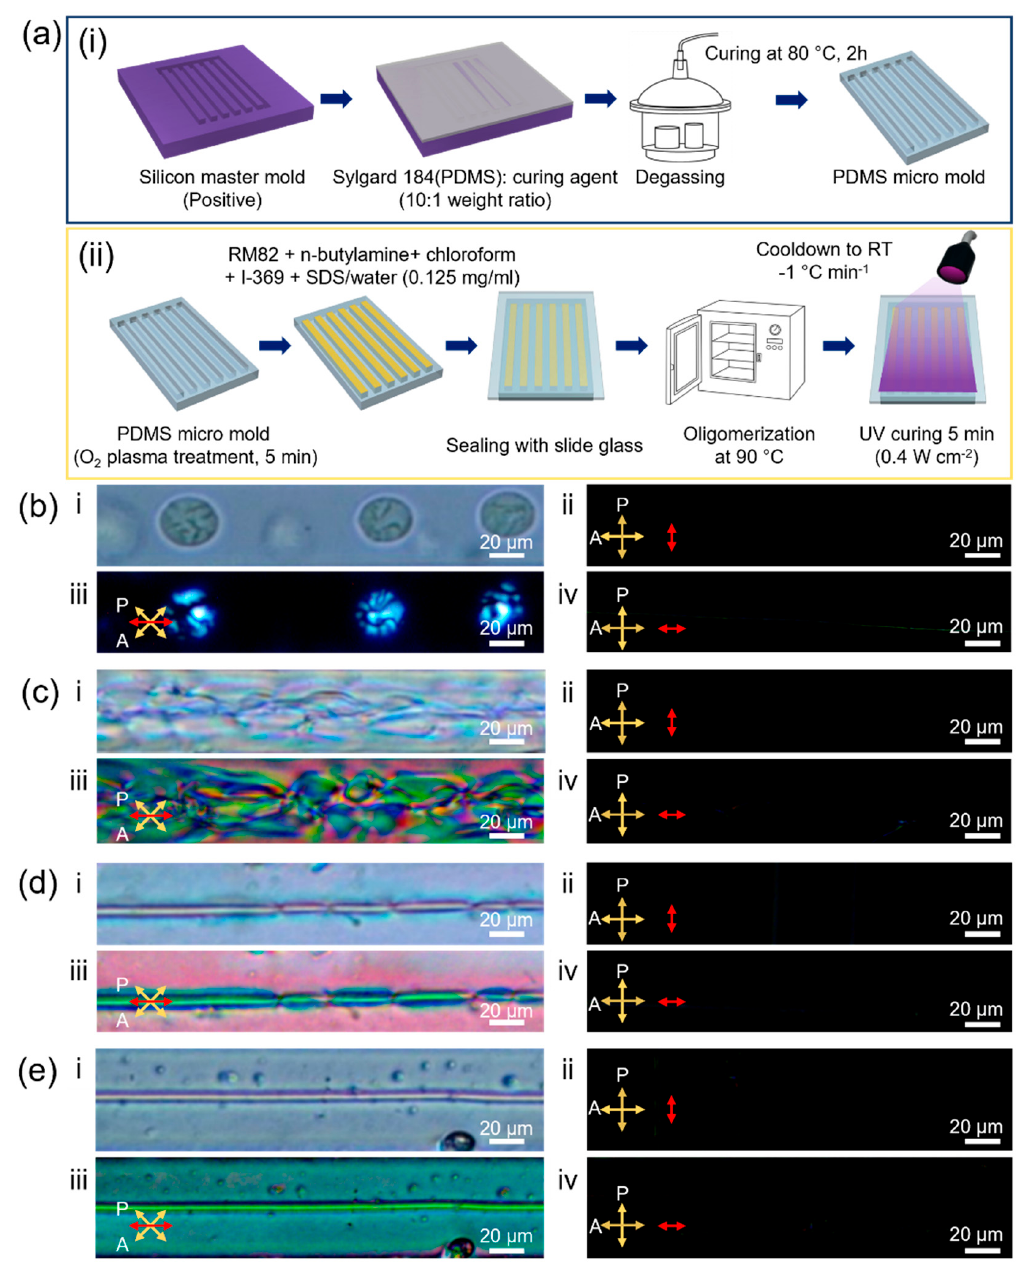
Figure 3. Spatial-confinement effects on shape changes in nematic liquid crystalline drops against thermal oligomerization times. ( a ) Schematic images of the construction of microchannel (i) and the thermal oligomerization procedure with spatial confinement (ii). (b-e) Shape transition of liquid crystalline oligomers from spherical to linear fiber geometry at different oligomerization times of ( b ) 6 h, ( c ) 12 h, ( d ) 24 h, and ( e ) 25 h. Scale bars are 20 μ m. (i) Optical microscope image and (ii–iv) cross-polarized optical microscope images with a different directional offset of the micro-channel from the analyzer: (ii) 0°, (iii) 45°, and (iv) 90°. The red arrow indicates the long axis of the micro-channel.